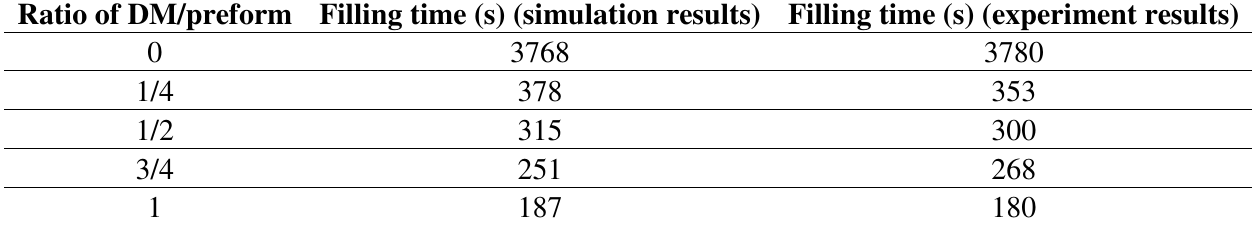
Table 1. Relationship of ratio of diversion medium area and filling time.